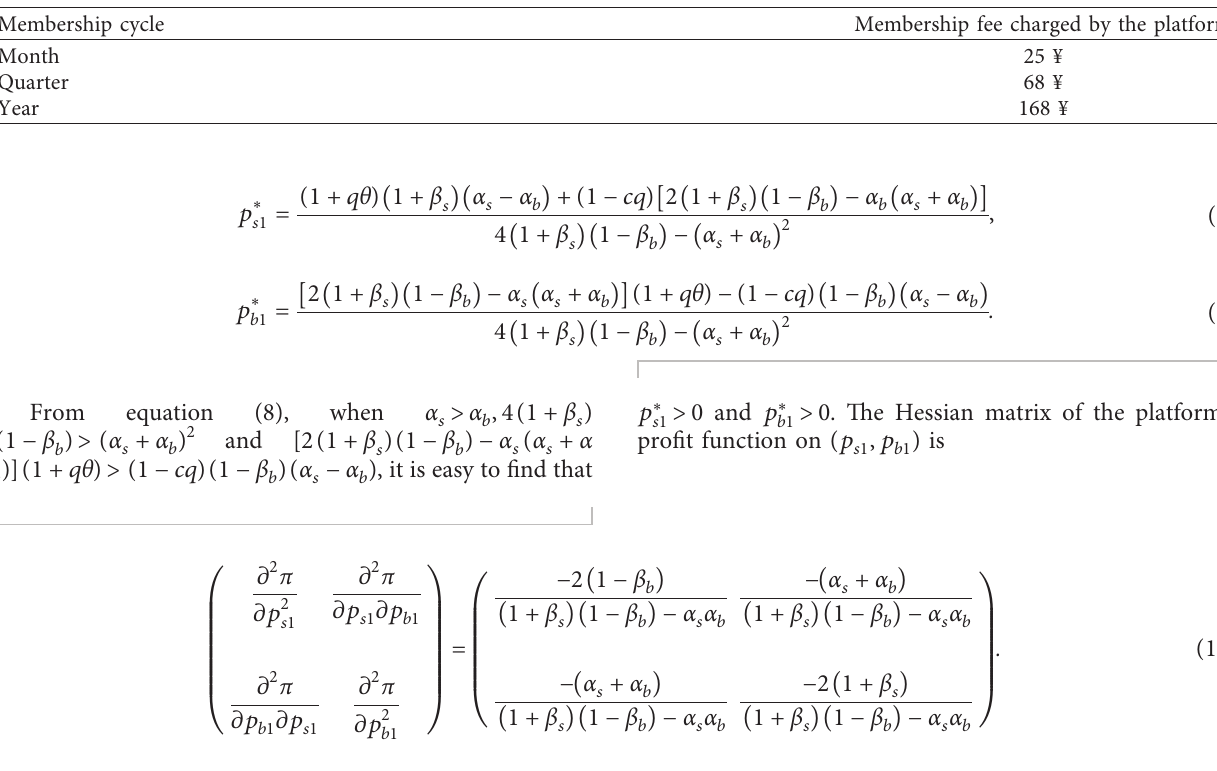
Table 2: Membership fee of